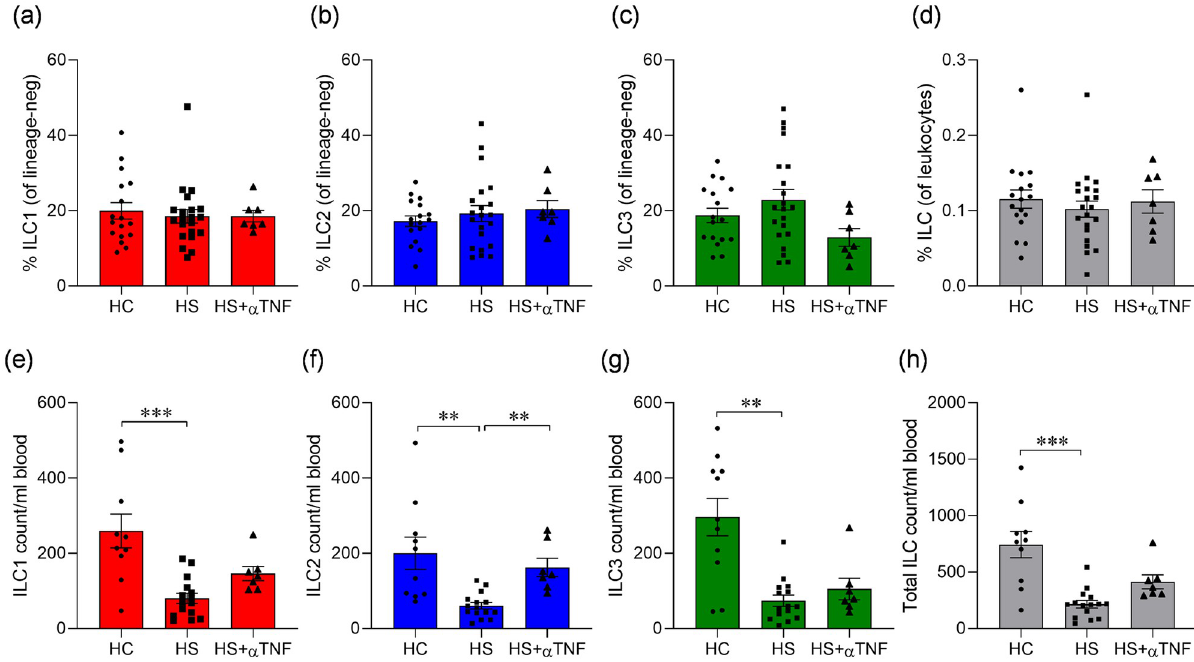
Fig 4. Frequencies and absolute numbers of ILC in the blood of hidradenitis suppurativa (HS) patients on anti-TNF treatment or non-biologics, compared to healthy controls (HC). PBMC were analysed by flow cytometry for frequencies of ILC types 1 (ILC1), 2 (ILC2) and 3 (ILC3) and total ILC. ILC were defined as CD45 + CD127 + lineage-negative, with ILC1 defined as CD117 - CD161 + , ILC2 defined as CD294 + and ILC3 defined as CD117 + NKP44 +/- . Lineage ‘cocktail’ included antibodies specific for CD1a, CD3, CD11c, CD14, CD19, CD34, CD94, CD123, CD303, FC ε RI, TCR αβ and TCR γδ . Precision count beads were used to calculate cell numbers. (a-d) average ( ± SEM) frequency of ILC1, ILC2 and ILC3 (% of lineage-negative cells (a-c) or total ILC (% of leukocytes) (d) in blood of healthy controls (HC, n = 10), and HS patients on non-biologic therapy (HS, n = 21) or anti-TNF (HS+ α TNF, n = 7). (e-h) cell counts ( ± SEM) of ILC1, ILC2, ILC3 and total ILC per ml of blood in healthy controls (HC, n = 10), and HS patients on non-biologic therapy (HS, n = 15) or anti-TNF (HS+ α TNF, n = 7). �� P < 0.01, ��� P < 0.001 using Kruskal-Wallis test with Dunn’s multiple comparisons.